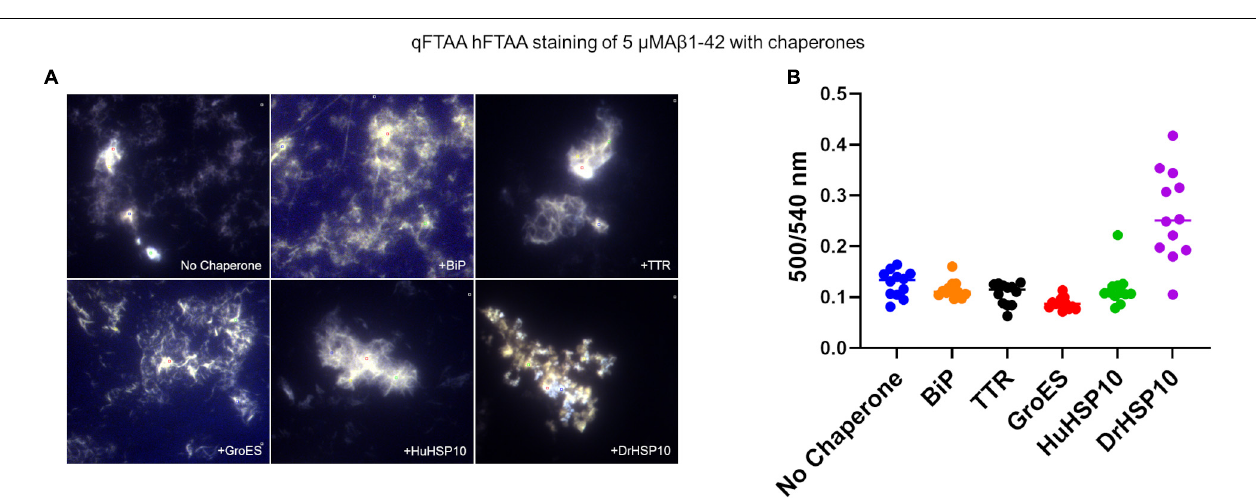
FIGURE 4 | Amyloid staining with luminescent conjugated oligothiophenes (LCOs) of A β 1–42 fibrils formed in the absence or presence of different chaperones. (A) Representative hyperspectral micrographs of fibrils stained with the LCOs hepta-formyl thiophene acetic acid (hFTAA) and quadro-formyl thiophene acetic acid (qFTAA). (B) Plot of intense regions of interest (ROIs) of qFTAA:hFTAA emission intensity ratio (500/540 nm) from the hyperspectral micrographs. Complete set of micrographs in Supplementary Figure 3 . Concentrations during fibrillation: A β 1–42, 5 µ M, chaperones 1 µ